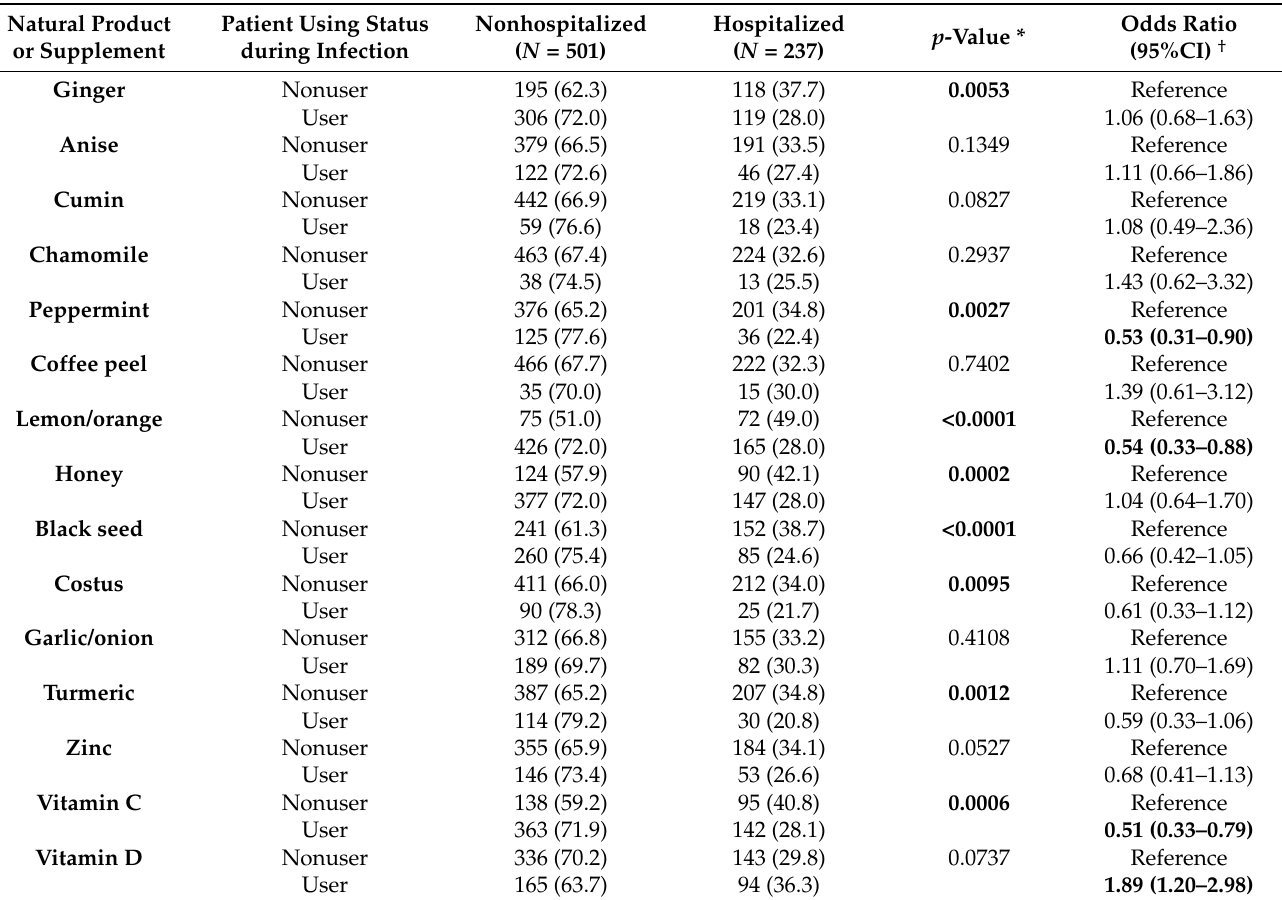
Table 4. Association between use of dietary or herbal supplements during infection with COVID-19 and hospitalization for COVID 19 treatment, before and after adjustment in multivariate logistic regression analysis. Natural Product or